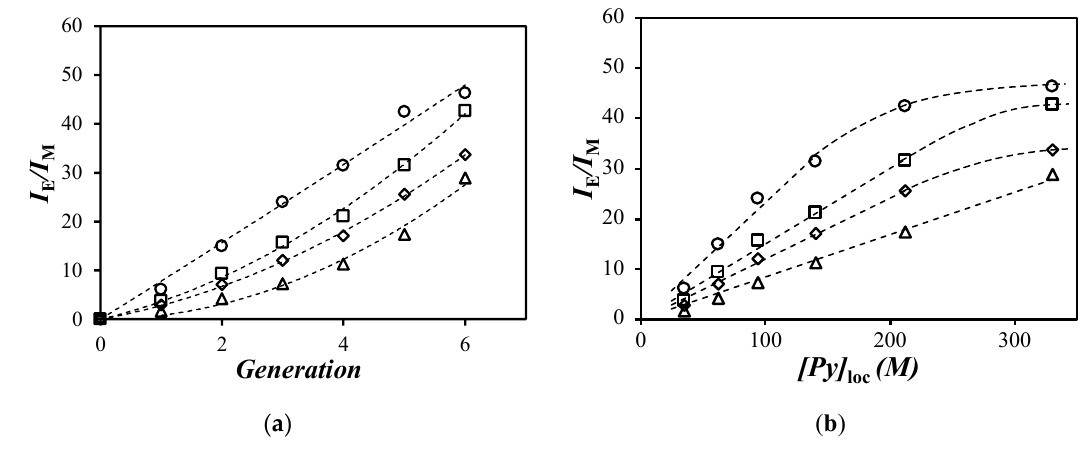
Figure 2. Plot of the I E / I M ratios for each Py x -G( N ) dendron in ( ) toluene, ( ) tetrahydrofuran (THF) [29], ( ) DMF, and ( ) DMSO versus ( a ) generation number and ( b ) the [ Py ] loc .